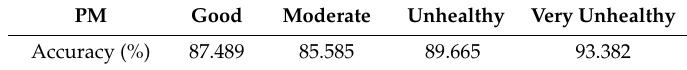
Table 6. The result of discriminant for movement of PM by wind